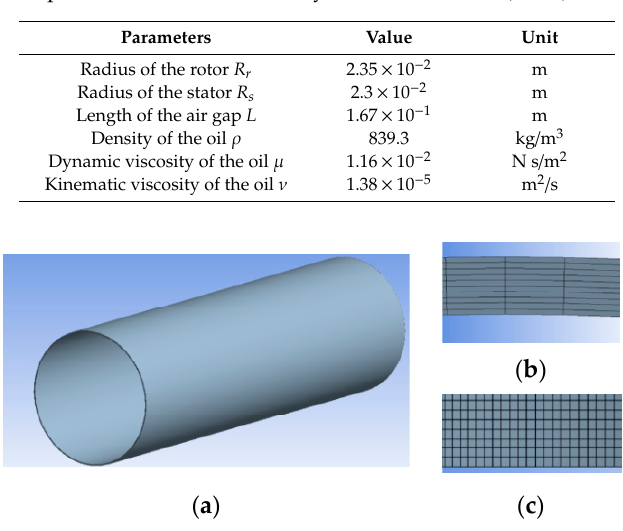
Figure 5. CFD simulation model. ( a ) Geometry of the air gap. ( b ) Radial grid of air gap. ( c ) Axial grid of air gap. Table 2. CFD simulation parameter setting.